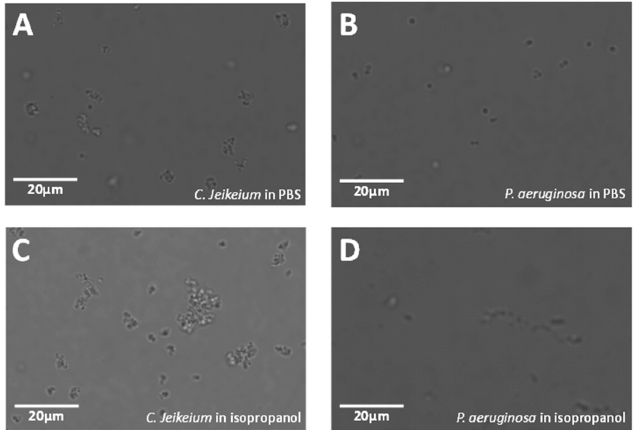
Figure 6. Comparison of images of C. jeikeium and P. aeruginosa in PBS and isopropanol. ( A , C ) present C. jeikeium in PBS and in isopropanol, respectively. ( B , D ) depict P. aeruginosa in PBS and in isopropanol, respectively. Scale bars: 20 µm.